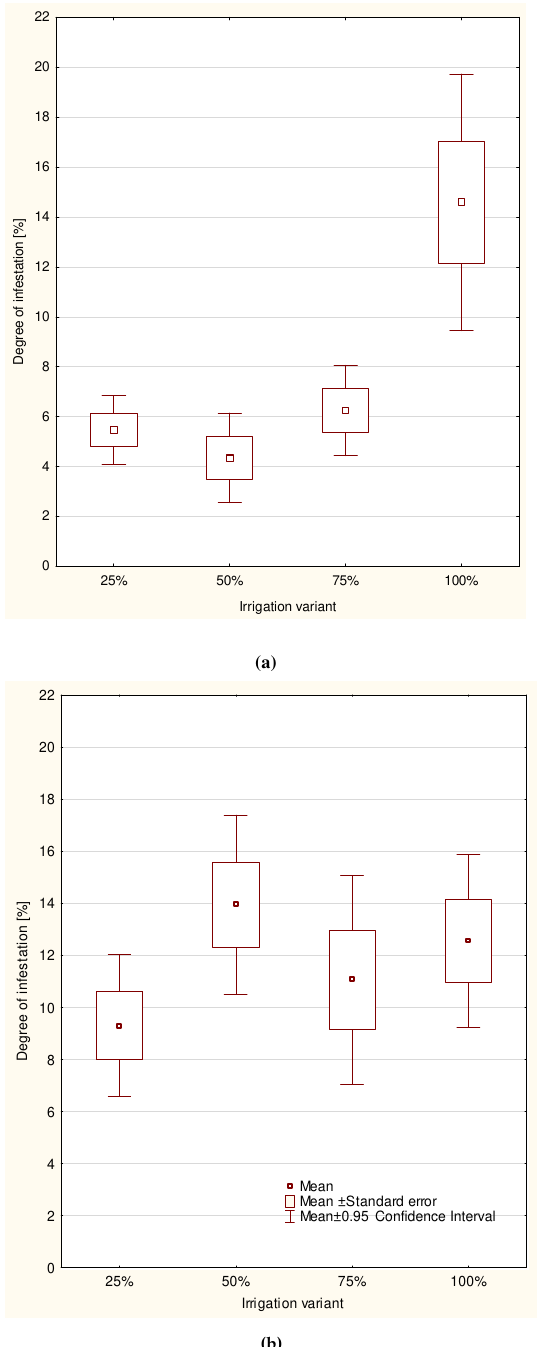
Figure 1. The mean degree of infested leaves of the sessile oak in 2015 ( a ) and in 2016 ( b ) for each variant including standard errors and confidence intervals.